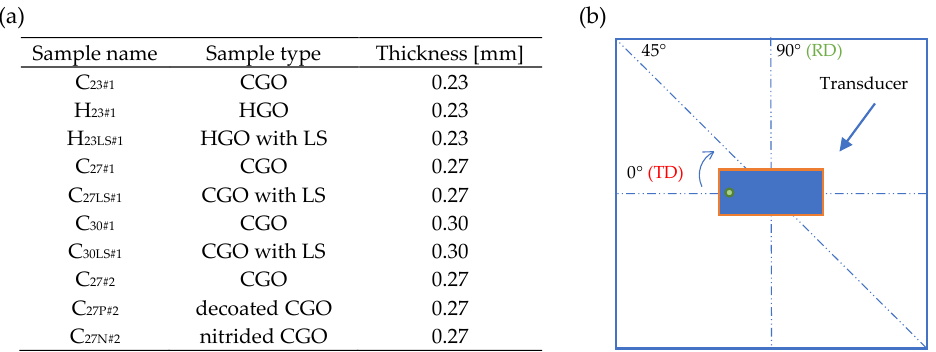
Figure 2. Samples and measuring procedure: ( a ) designation of the samples, ( b ) testing procedure; note: #1 and #2 in indexes refers to the producer no. 1 and no. 2 of the utilized steel sheets. For each sample, the measurements were made for different angular positions of the transducer between 0 ◦ and 180 ◦ using an angular step of 1.8 ◦ (for 0 ◦ position the main axis of the transducer is along the axis transverse (TD) to the rolling direction of steel; for 90 ◦ position the main axis of the transducer is along the rolling direction of steel—RD). The excitation signal was sinusoidal with a frequency of 10 Hz. The field strength obtained during the measurements was about 1.6 kA/m. MBN signals were collected via a